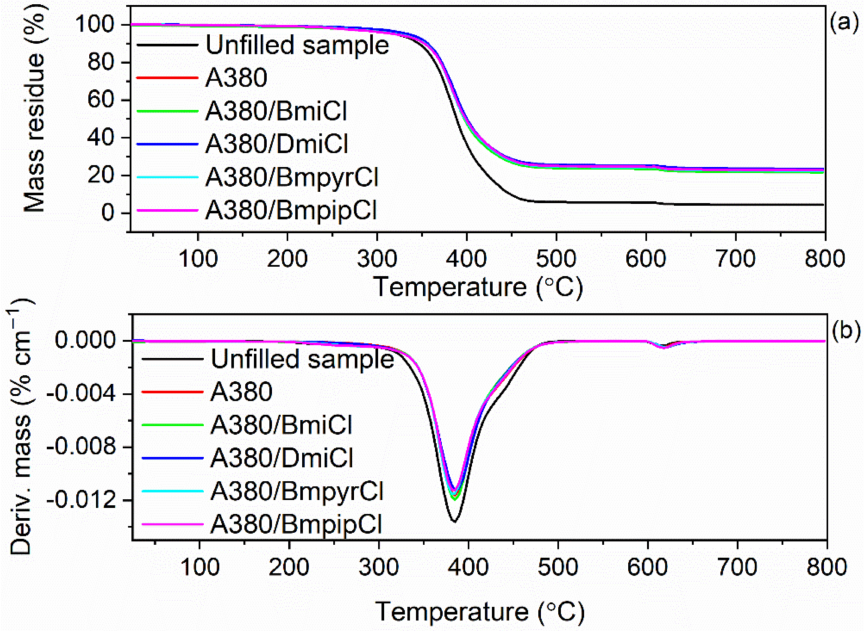
Figure 10. TG and DTG curves of the silica-filled NR vulcanizates containing ILs with chloride anion: ( a ) TG curves; ( b ) DTG